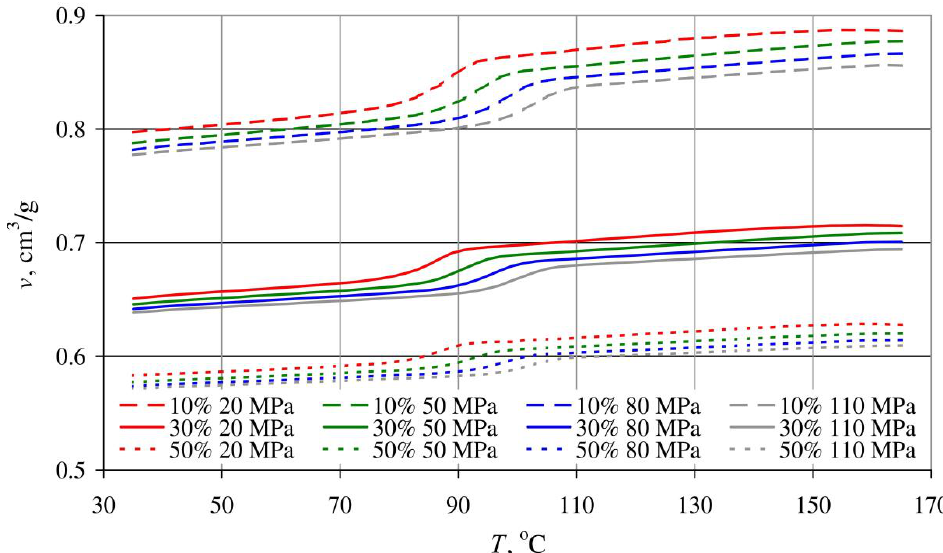
Figure 21. Dependence of the specific volume v on temperature T of blends obtained with the same extruder screw rotational speed of 125 min − 1 and different bran contents: 10% — dashed lines, 30% — solid lines, 50% — dotted lines, for various pressure values.